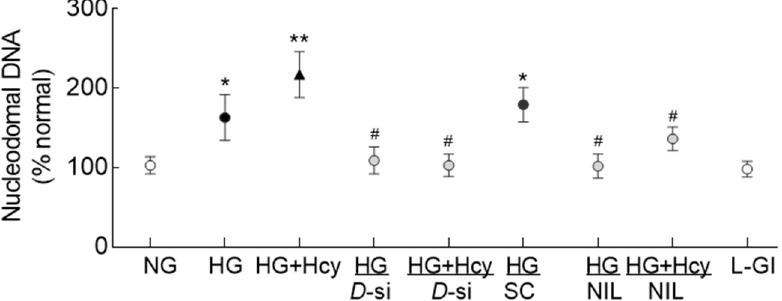
Figure 6. Homocysteine and endothelial cell apoptosis. Apoptosis of HRECs was quantified using a Cell Death Detection ELISA PLUS kit from Roche Diagnostics, and the values obtained from cells in normal glucose were considered as 100: NG and HG, cells in normal and high glucose, respectively; HG + Hcy, cells in high glucose and homocysteine; HG/ D -si and HG + Hcy/ D -si, Drp1 -siRNA transfected cells in high glucose or high glucose + homocysteine, respectively; HG/SC, nontargeting scrambled RNA transfected cells in high glucose; HG/NIL and HG + Hcy/NIL, cells in the presence of NIL in high glucose or high glucose + homocysteine, respectively; L-Gl, 20 mM L-glucose; * and ** p < 0.05 vs. NG and HG, respectively; # p > 0.05 vs. NG.